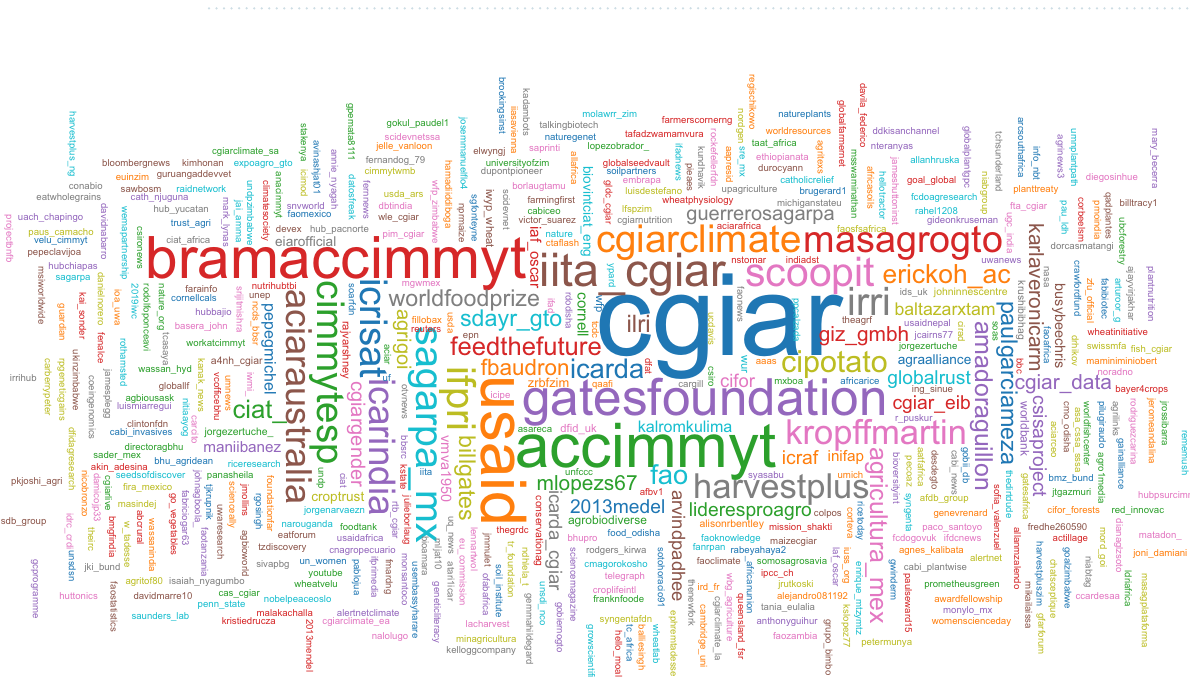
Figure 7. Word cloud of account mentions identified in tweets containing either @CIMMYT or